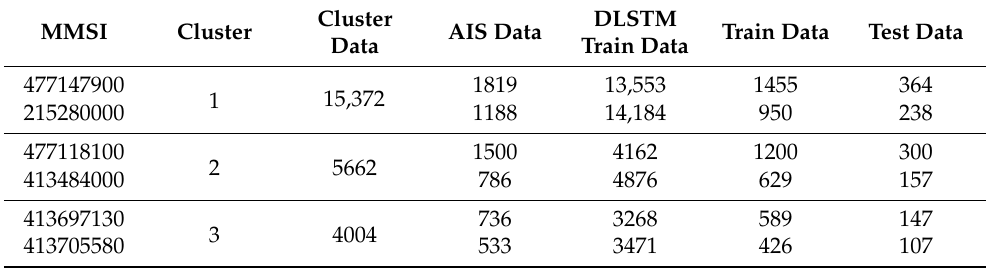
Figure 8. Clustering results of the DBSCAN. Green, cluster 1; Blue, cluster 2; Yellow, cluster 3; Purple, cluster 4. Table 2. Description of samples in this